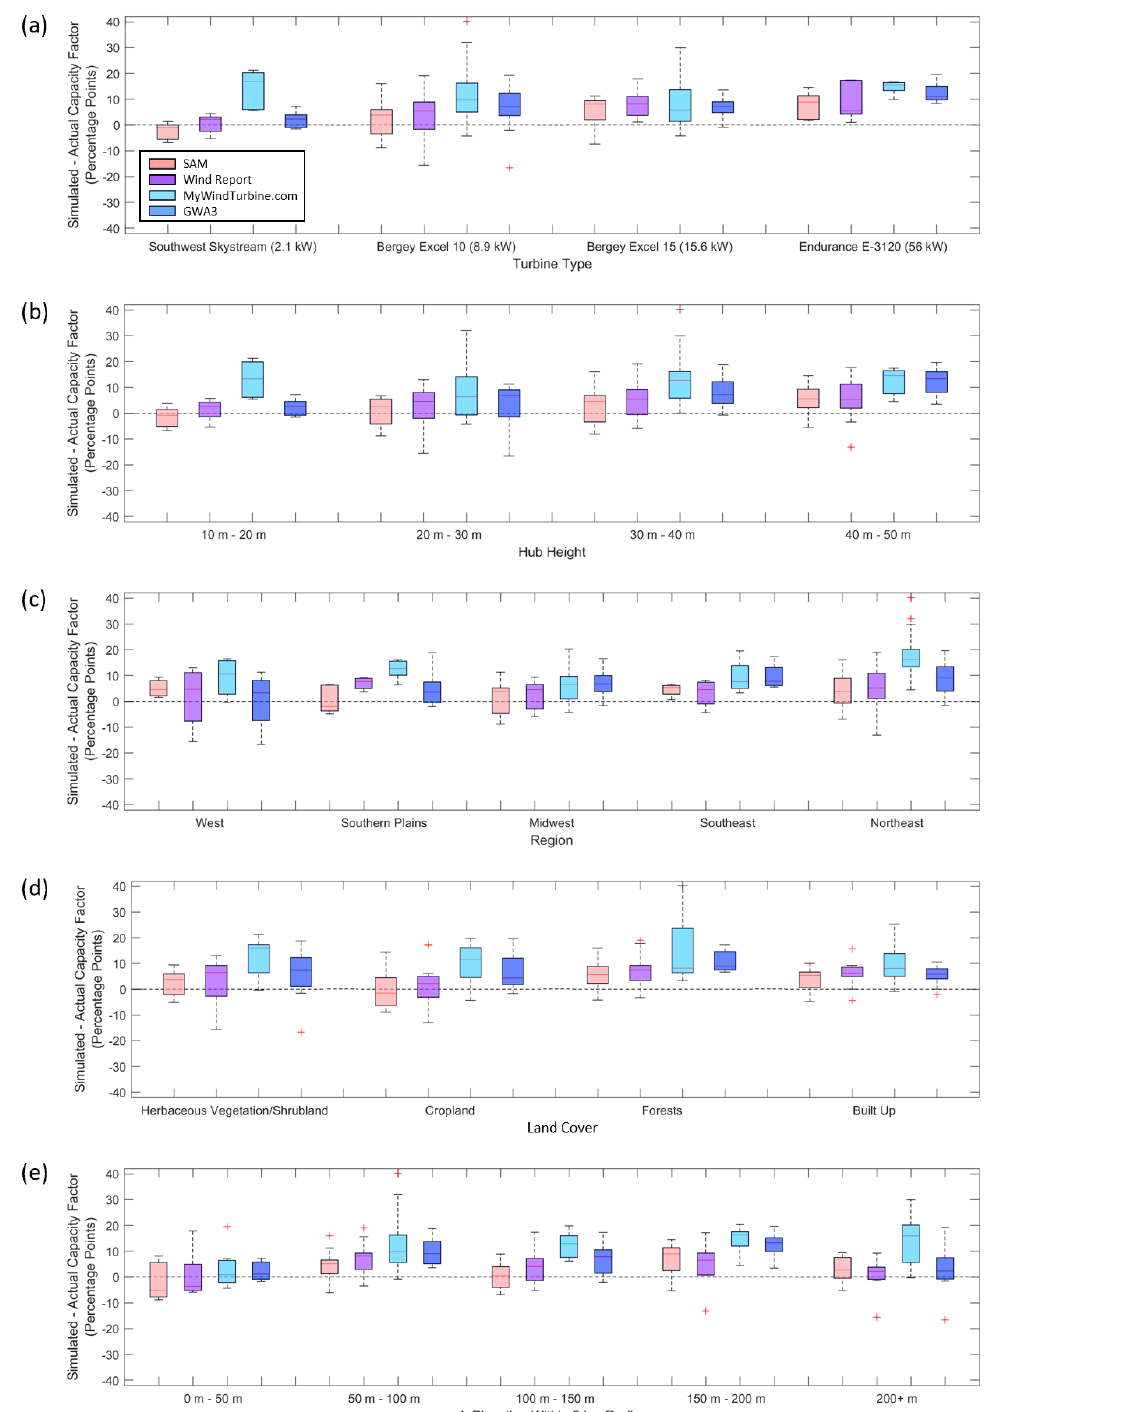
Figure 7. Capacity factor error (simulated minus observed capacity factor) according to (a) turbine type, (b) hub height, (c) region, (d) land cover, and (e) elevation difference across 55 small wind turbines. The median error metrics are indicated with the red lines; the 25th and 75th percentiles form the blue boxed range; the minimum and maximum error metrics, excluding outliers, are in black; and outliers are indicated with red plus